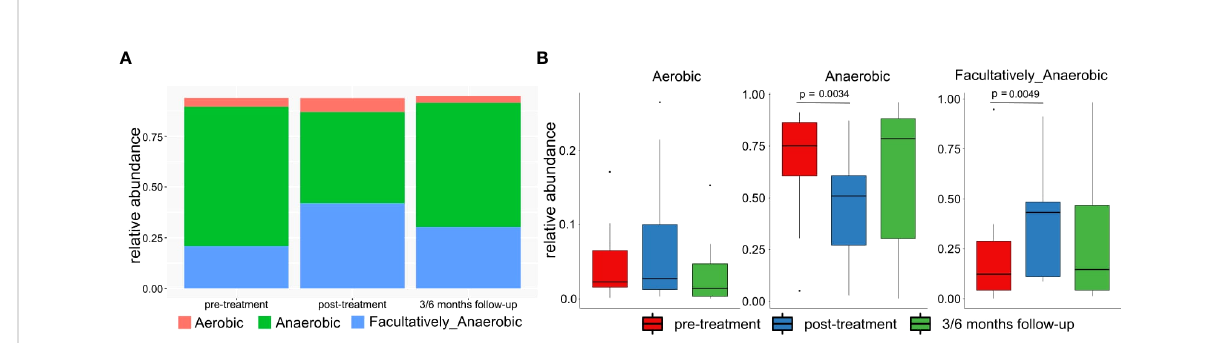
after treatment and in 3/6 months